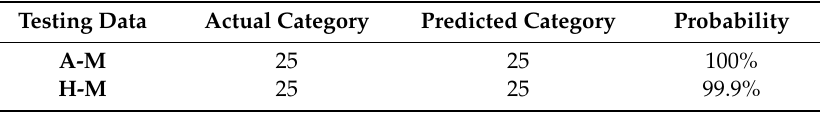
Table 7. Experimental verification results for multi-damage.